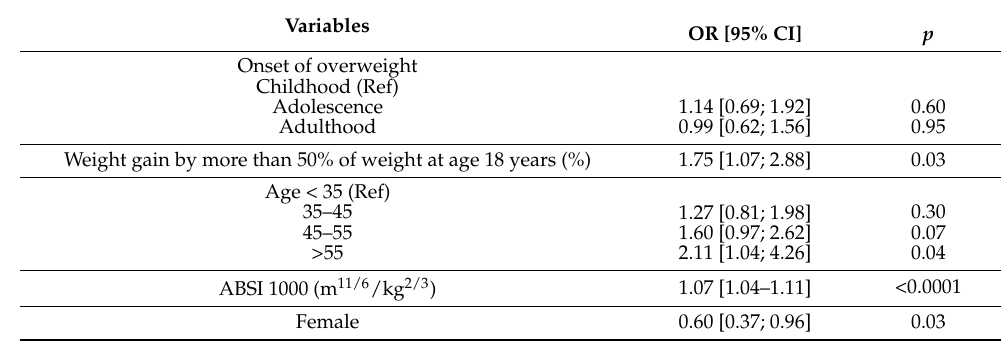
Table 3. Multivariate analysis of factors associated with metabolic syndrome using propensity score